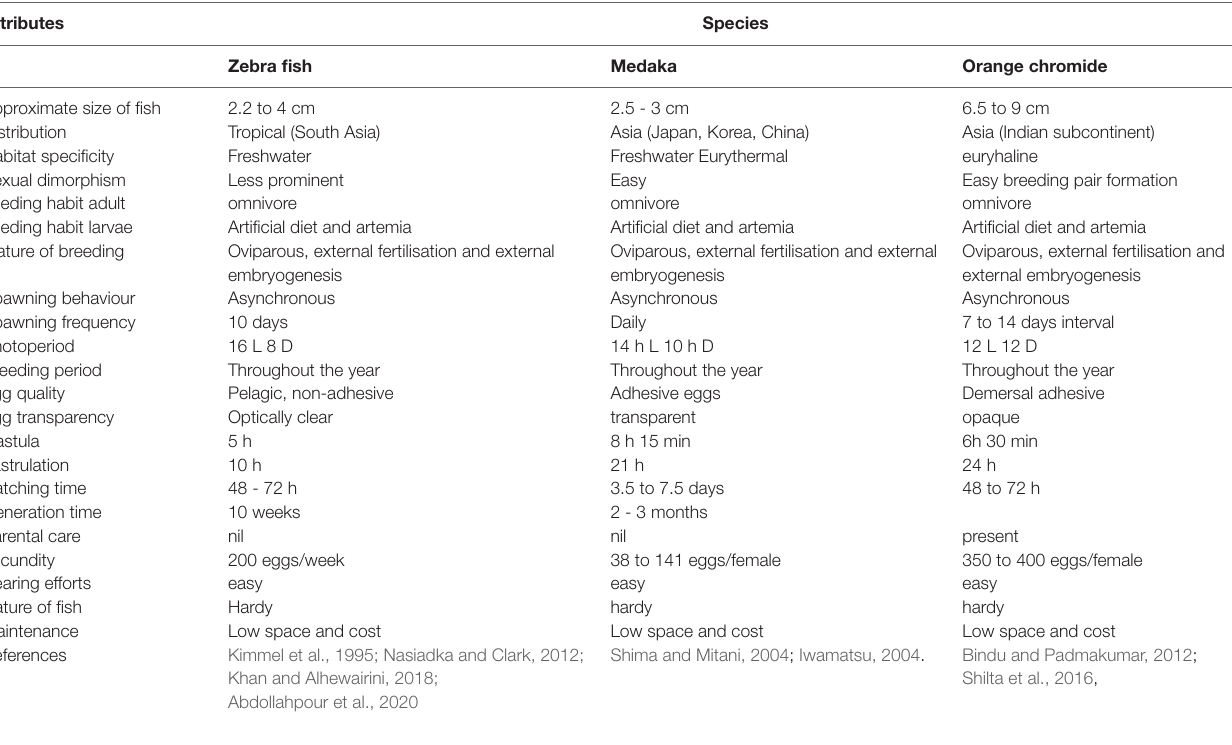
TABLE 2 | Comparison of characteristic of established model fishes to E. maculatus.